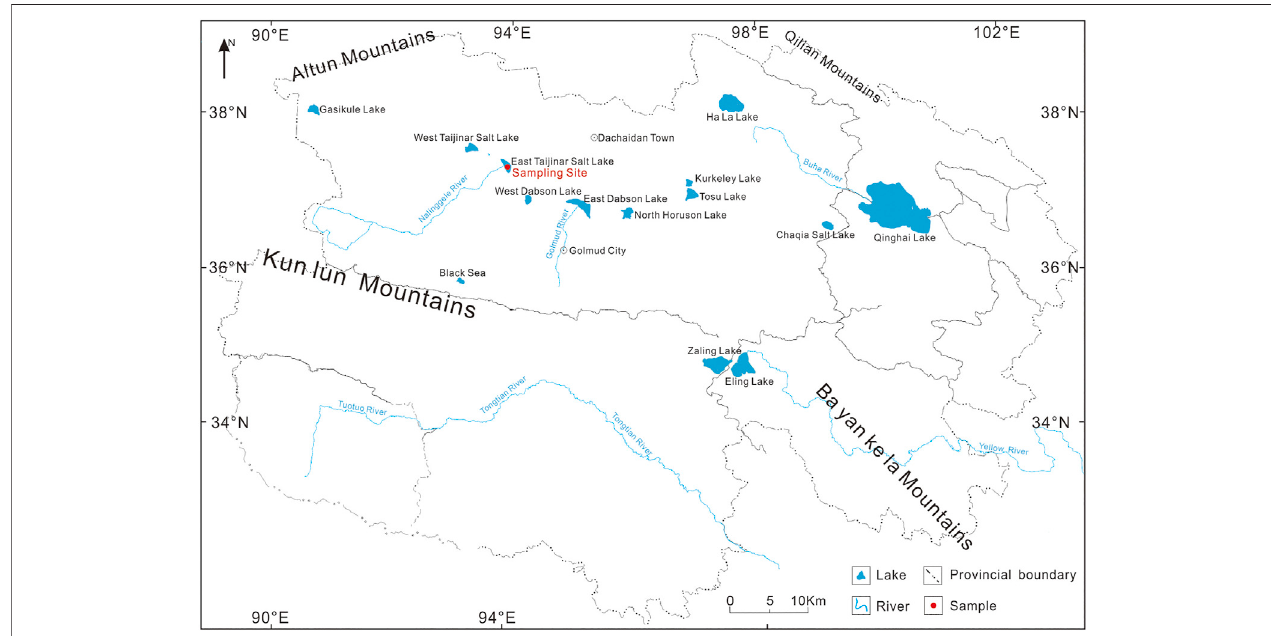
FIGURE 1 | Map of the sampling site and lakes in the Qinghai Province